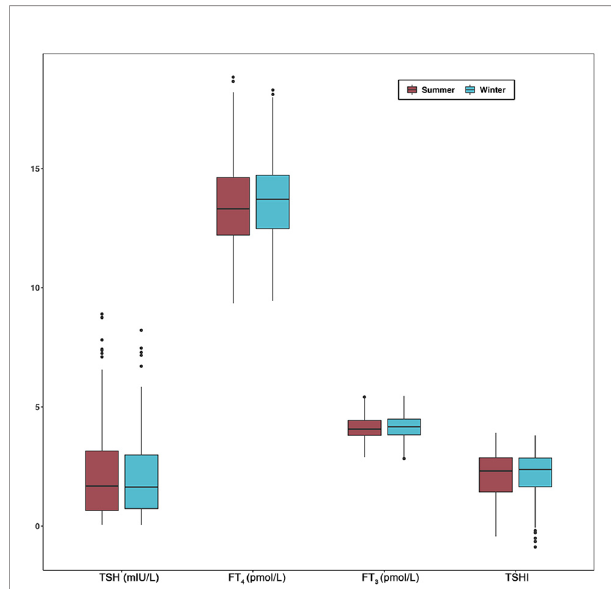
FIGURE 3 | Comparisons of TSH, FT 4 , FT 3 , and TSHI between summer and winter in longitudinal analysis. Box plot indicates upper and lower quartiles (box) with median (central line). Whiskers indicate upper and lower extremes. Abbreviations: TSH, thyrotropin; FT 3 , free triiodothyronine; FT 4 , free thyroxine; TSHI, TSH index; TPOAb, thyroid peroxidase